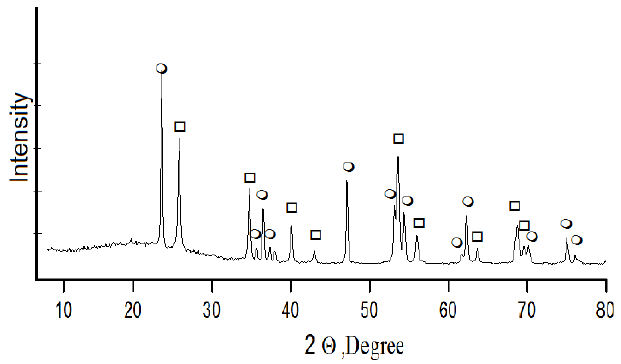
Figure 5. Powder X-ray diffraction pattern of DTK titanium dioxide in the form of ο —anatase, □